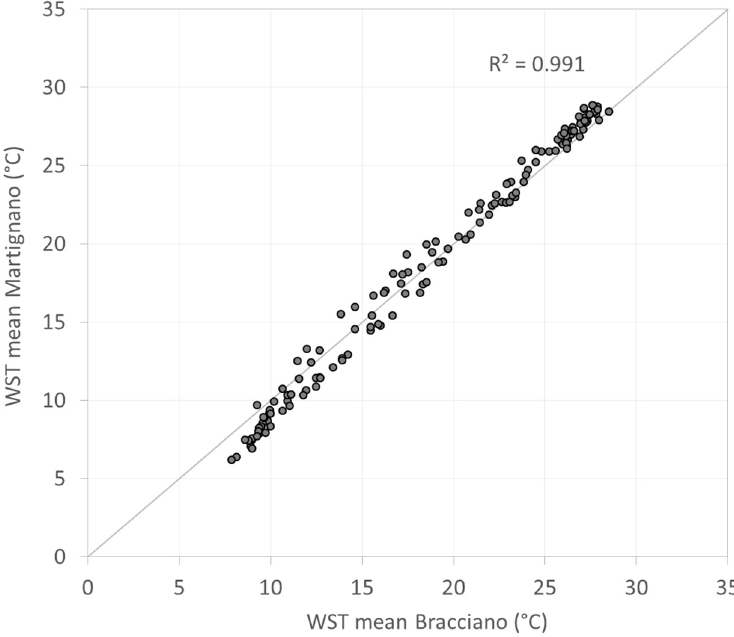
Figure 4. Scatter plot for comparing water surface temperatures derived from Landsat products from 2000 to 2019 for Lake Bracciano (horizontal axis) and Lake Martignano (vertical axis).